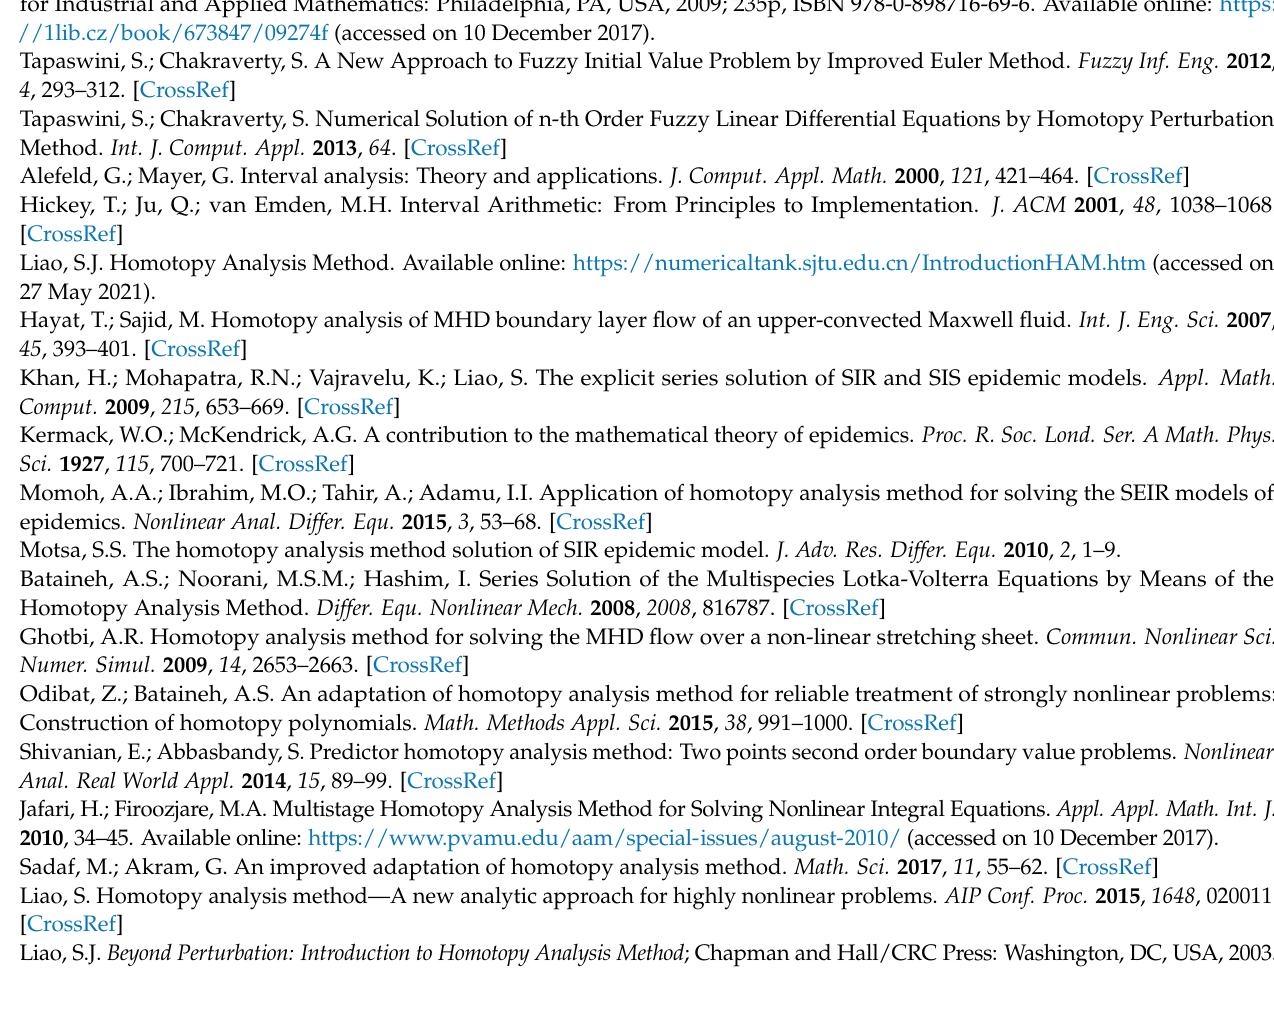
Figure A3. Plot of the maximum, center, and minimum of recovered humans under the intervals (cid:2010)(cid:3560) = [0.01,0.03] and (cid:2011)(cid:3556) = [0.01,0.015] .